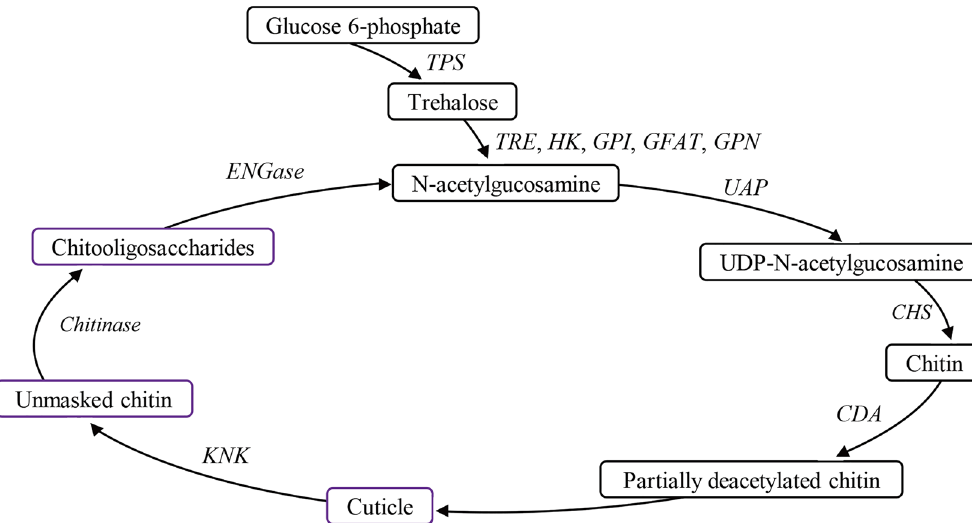
Figure 1. Key enzymes and genes involved in chitin biosynthesis and degradation in A. pisum . TPS , trehalose- 6-phosphate synthase gene; TRE , trehalase gene; HK , hexokinase gene; GPI , glucose-6-phosphate isomerase gene; GFAT , glutamine-fructose-6-phosphate aminotansferasr gene; GPN , glucosamine-6-phosphate-N- acetytransferase gene, UAP ; UDP-N-acetyglucosamine pyrophosphorylase gene; CHS , chitin synthase gene, Cht1 , 2 , 3 , 5 , 6 , 7 , 8 , 10 , eight chitinase genes; IDGF , imaginal disc growth factor gene; ENGase , endo-β-N- acetylgucosaminidase